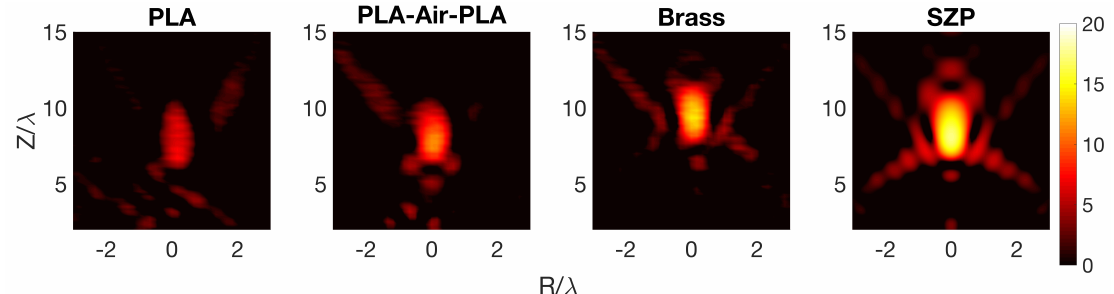
Figure 6. Intensity gain maps for experimental measurements and ideal SZP numerically obtained